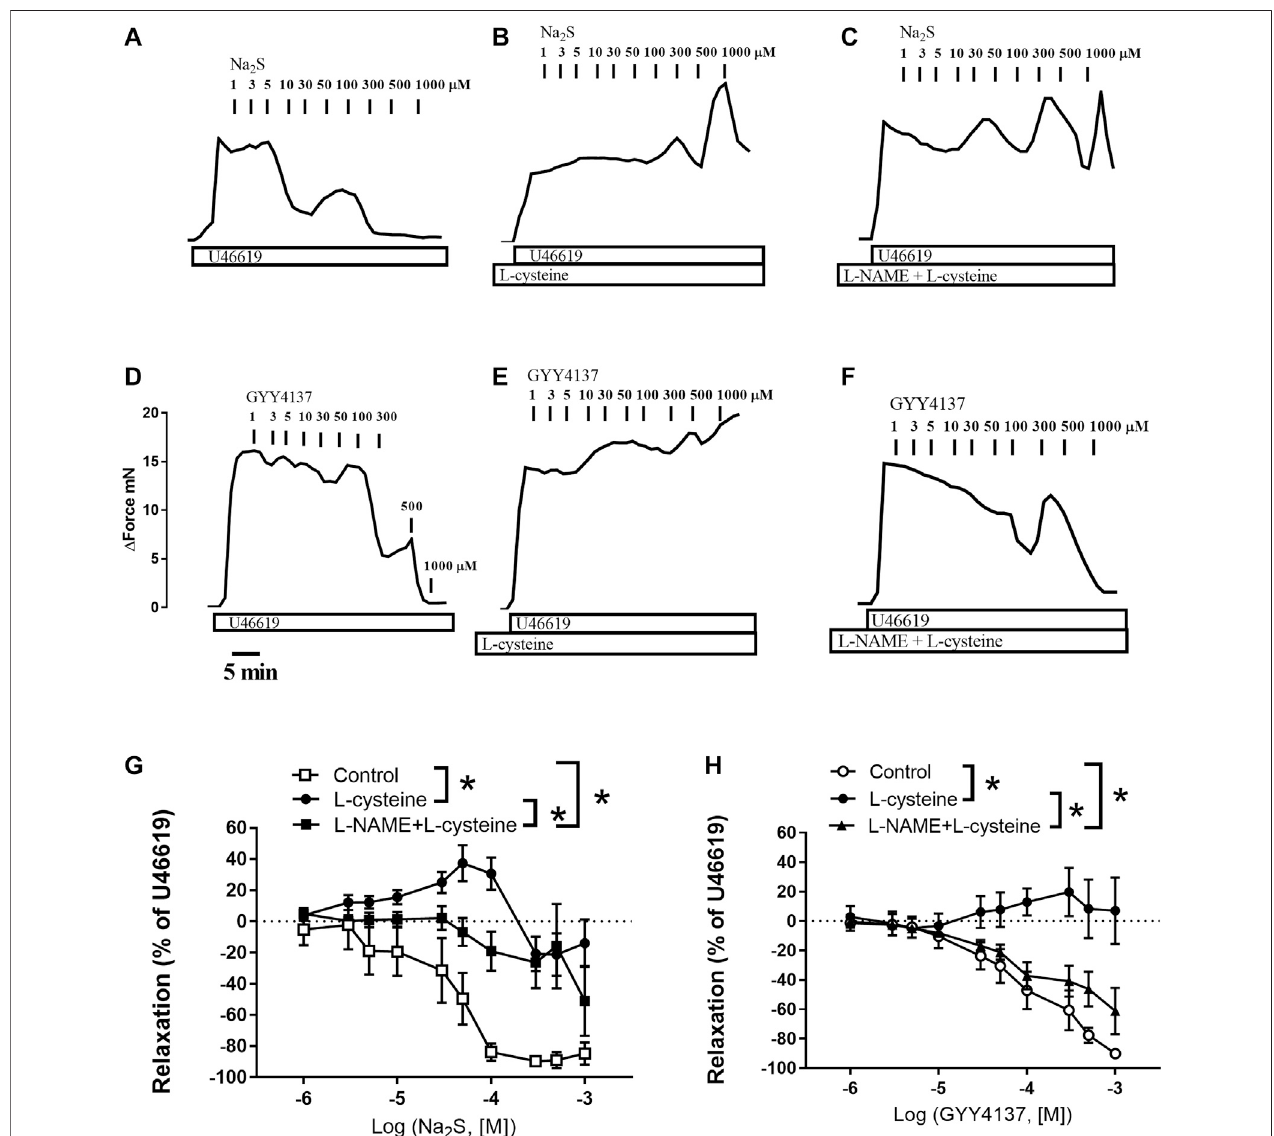
FIGURE 3 | Effect of L-cysteine and L-NAME incubation on Na 2 S and GYY4137 relaxations in rat small mesenteric arteries. Original traces showing the effect of increasing concentrations of Na 2 S in U46619-contracted preparations in (A) control conditions (B) in the presence of L-cysteine (1 mM), and (C) in the presence of L-cysteine and the nitric oxide synthase inhibitor, L-NAME (100 µM). Original traces showing the effect of increasing concentrations of GYY4137 in U46619-contracted preparationsin (D) controlconditions (E) inthepresenceofL-cysteine(1 mM),and (F) inthepresenceofL-cysteineandthenitricoxidesynthaseinhibitor,L-NAME (100 µM).ThehorizontalbarindicatestimeinminandtheverticalbarincreaseinforceinmN (G) AverageeffectofL-cysteinewithoutandwithL-NAMEonNa 2 S-induced vascular relaxation (H) Average effect of L-cysteine without and with L-NAME on GYY4137-induced vascular relaxation. Data are means ± SEM ( n (cid:2) 6). * p < 0.05, two- way ANOVA.